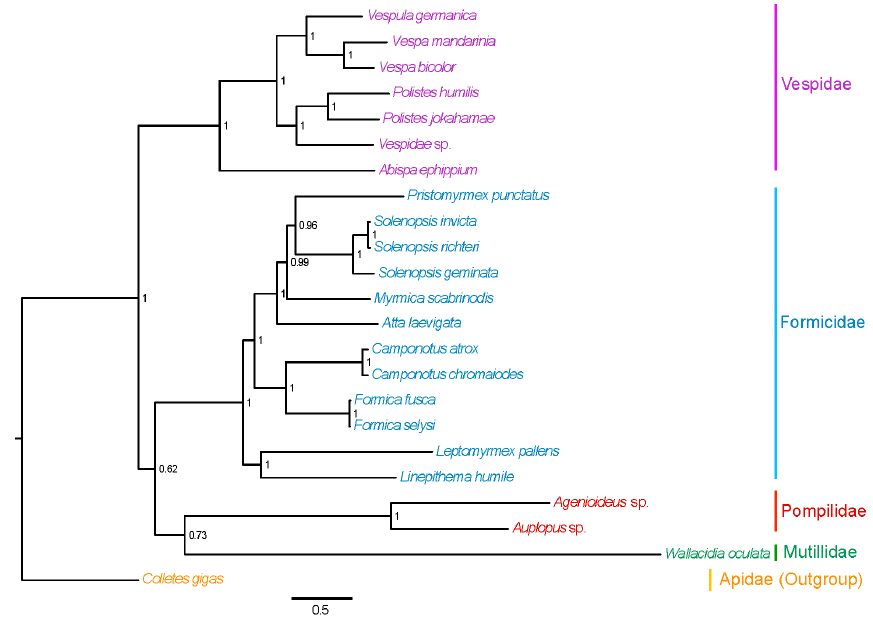
Figure 2. Bayesian phylogenetic tree of the superfamily Vespoidea of Hymenoptera based on the mitochondrial genome sequences. The number indicates the posterior probability of the corresponding node nearby.